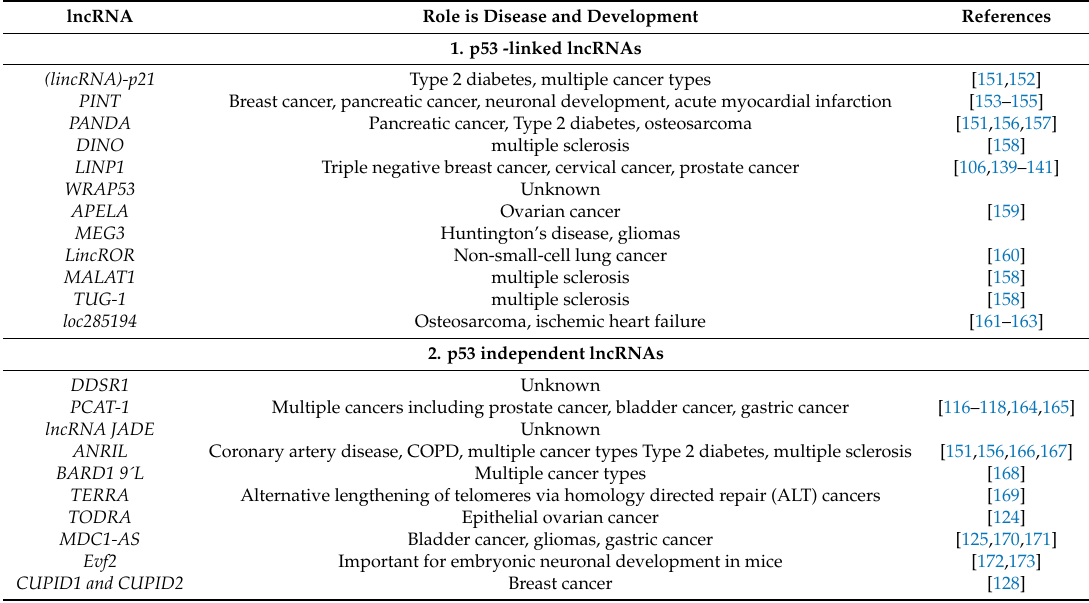
Table 2. Relevance of lncRNAs to development, disease, and inborn errors of metabolism. lncRNA Role is Disease and